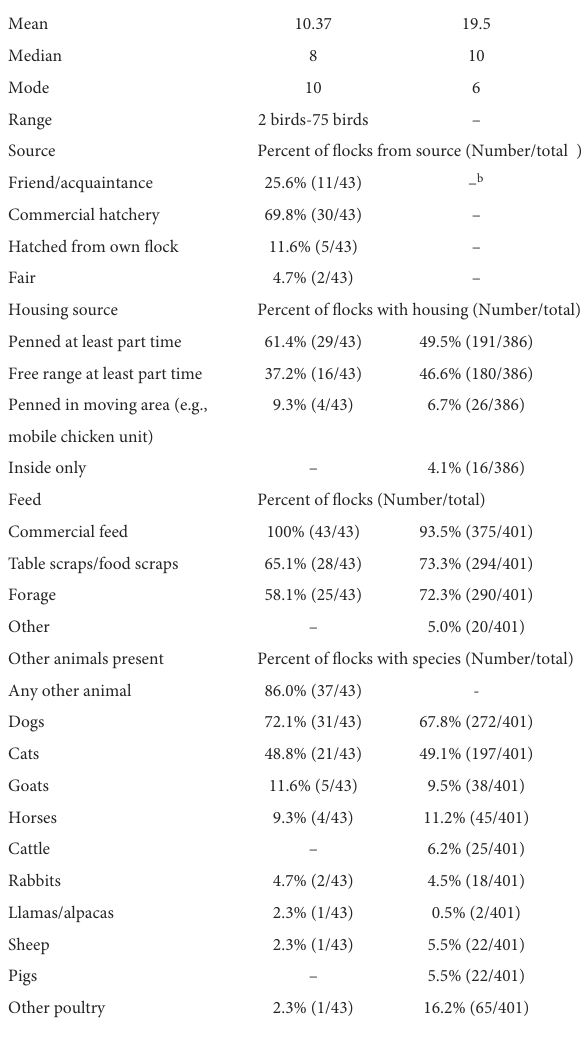
TABLE 1 Characteristics of flocks of backyard chickens in